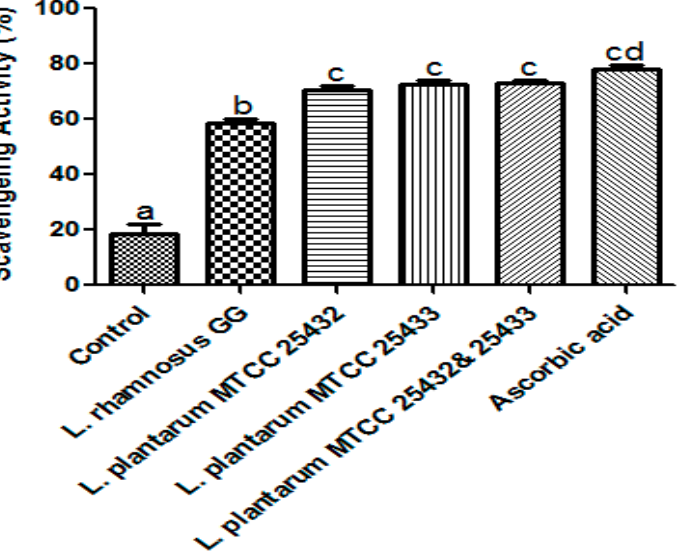
Figure 4. Antioxidant attribute; Significantly higher antioxidative potential of the soycurd fermented with the strain L. rhamnosus GG, L. plantarum MTCC 25432 (BBC32B), L. plantarum MTCC 25433 (BBC33) and L. plantarum MTCC 25432 (BBC32B) and MTCC 25433 (BBC33) combination in relation to ascorbic acid as a positive control and unfermented soymilk as negative control. The values are expressed as mean ± SEM of three independent experiments with significant difference ( p <